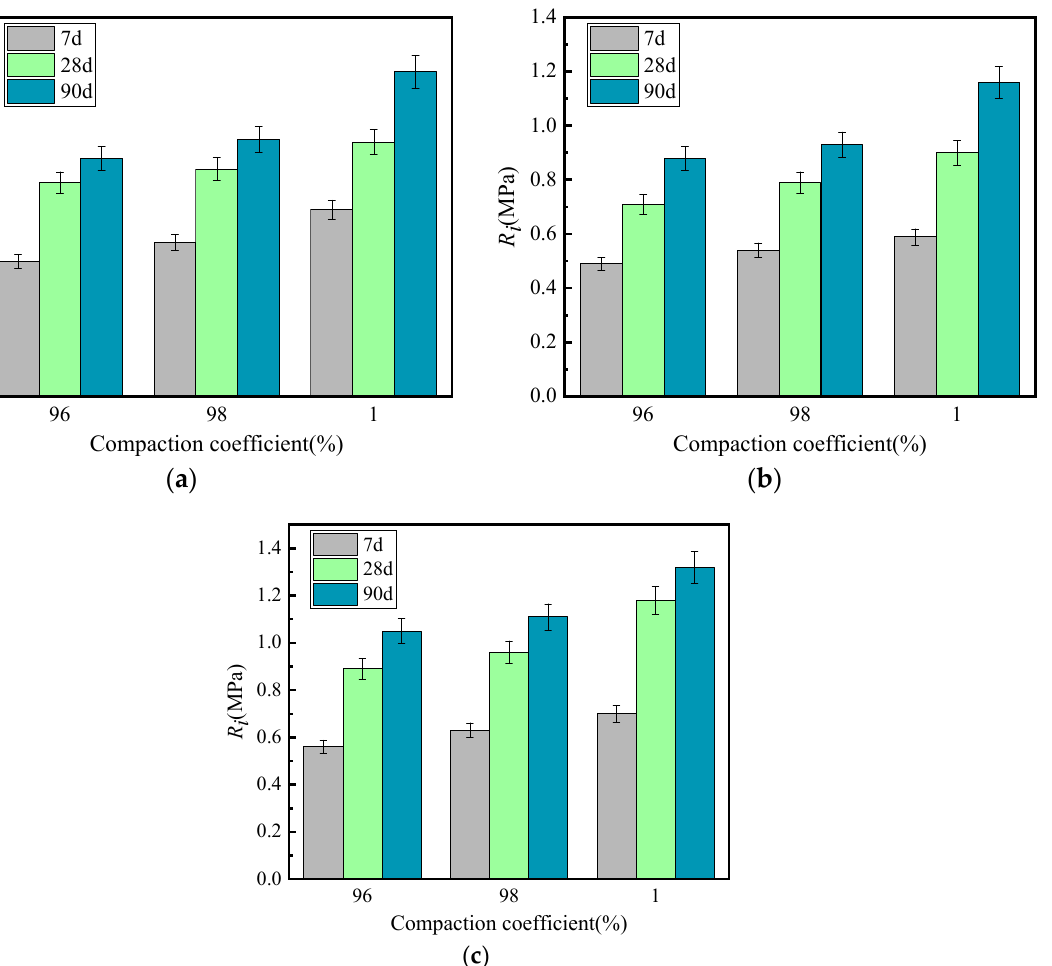
Figure 12. Growth law of splitting strength under different compaction coefficients. ( a ) GF1, ( b ) GF2, ( c ) VGM-30.